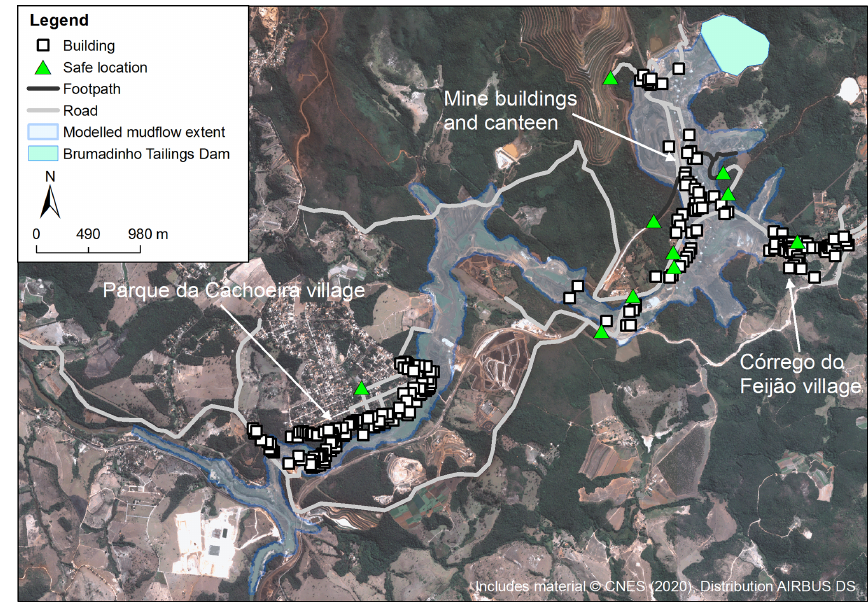
Figure 8. Location of buildings, safe locations and evacuation routes downstream of the Brumadinho tailings dams.